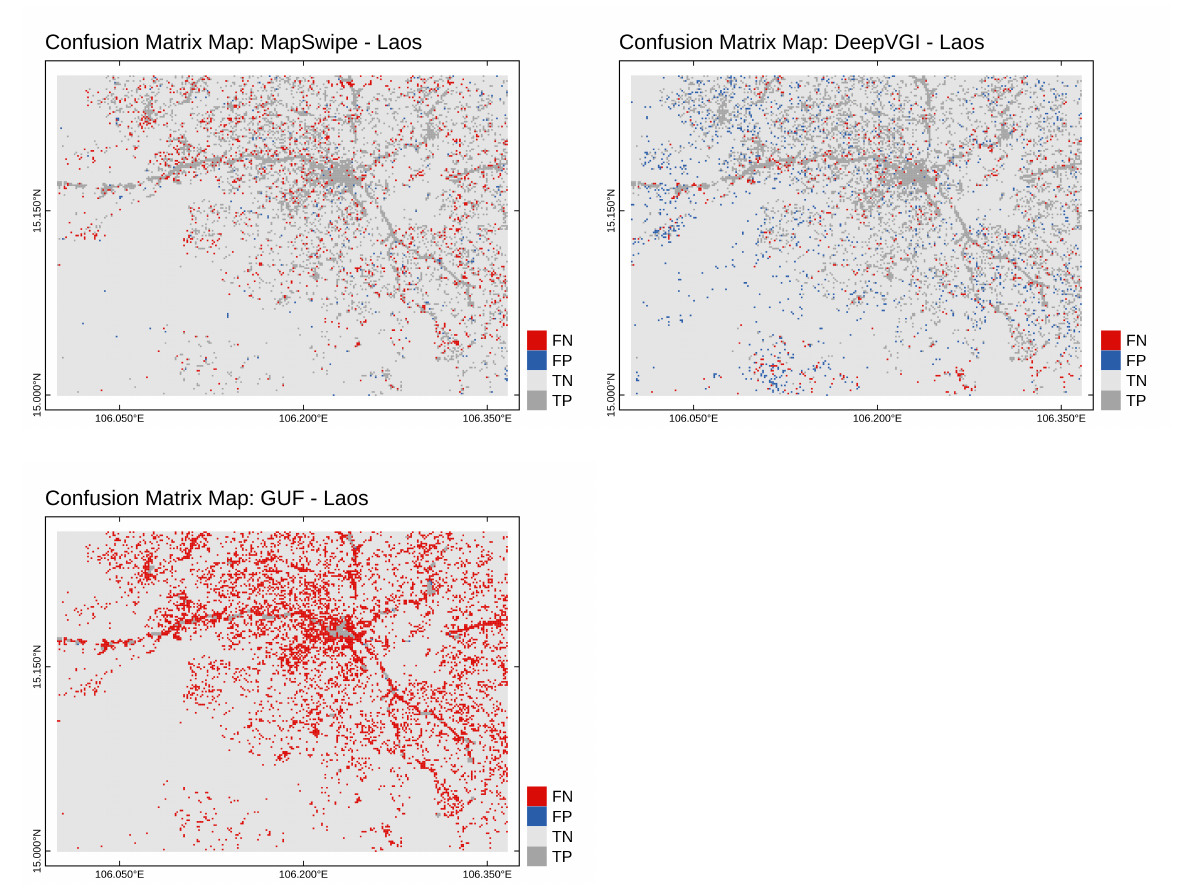
Figure 4. Map representation of the confusion matrix for Laos: Each map shows the spatial distribution of correct “building” (TP) and “no building” (TN) classifications for a specific method in the testing area. Incorrect classifications are split into false positives (FP) and false negatives (FN). Each pixel corresponds to a single task/satellite imagery